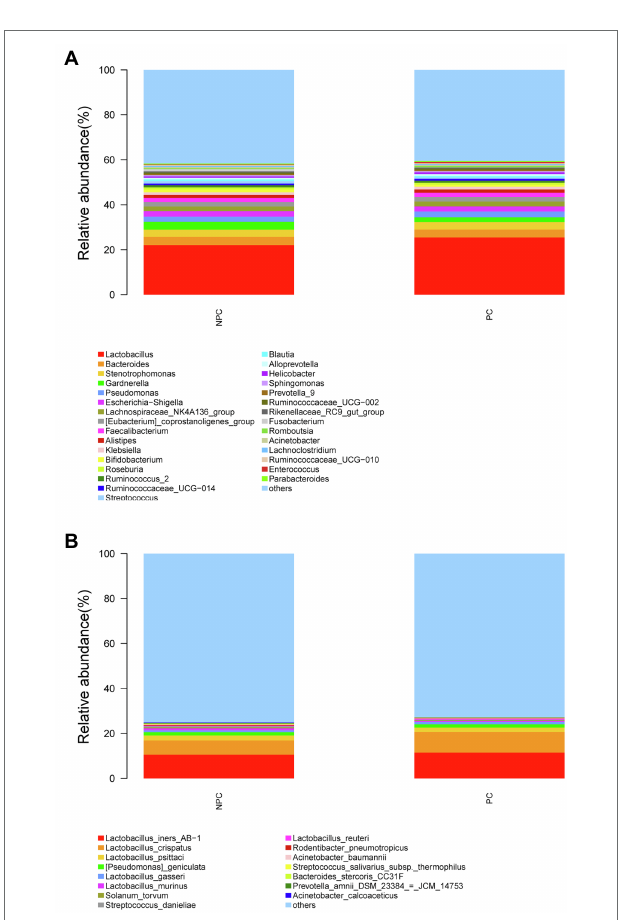
FIGURE 8 | Cervical microbial composition of pregnant and non-pregnant groups. (A) The relative abundance of the top 30 genera in the cervical canal at the genus level in pregnant and non-pregnant groups. (B) The relative abundance of the top 15 genera in the cervical canal at the species level in pregnant and non-pregnant